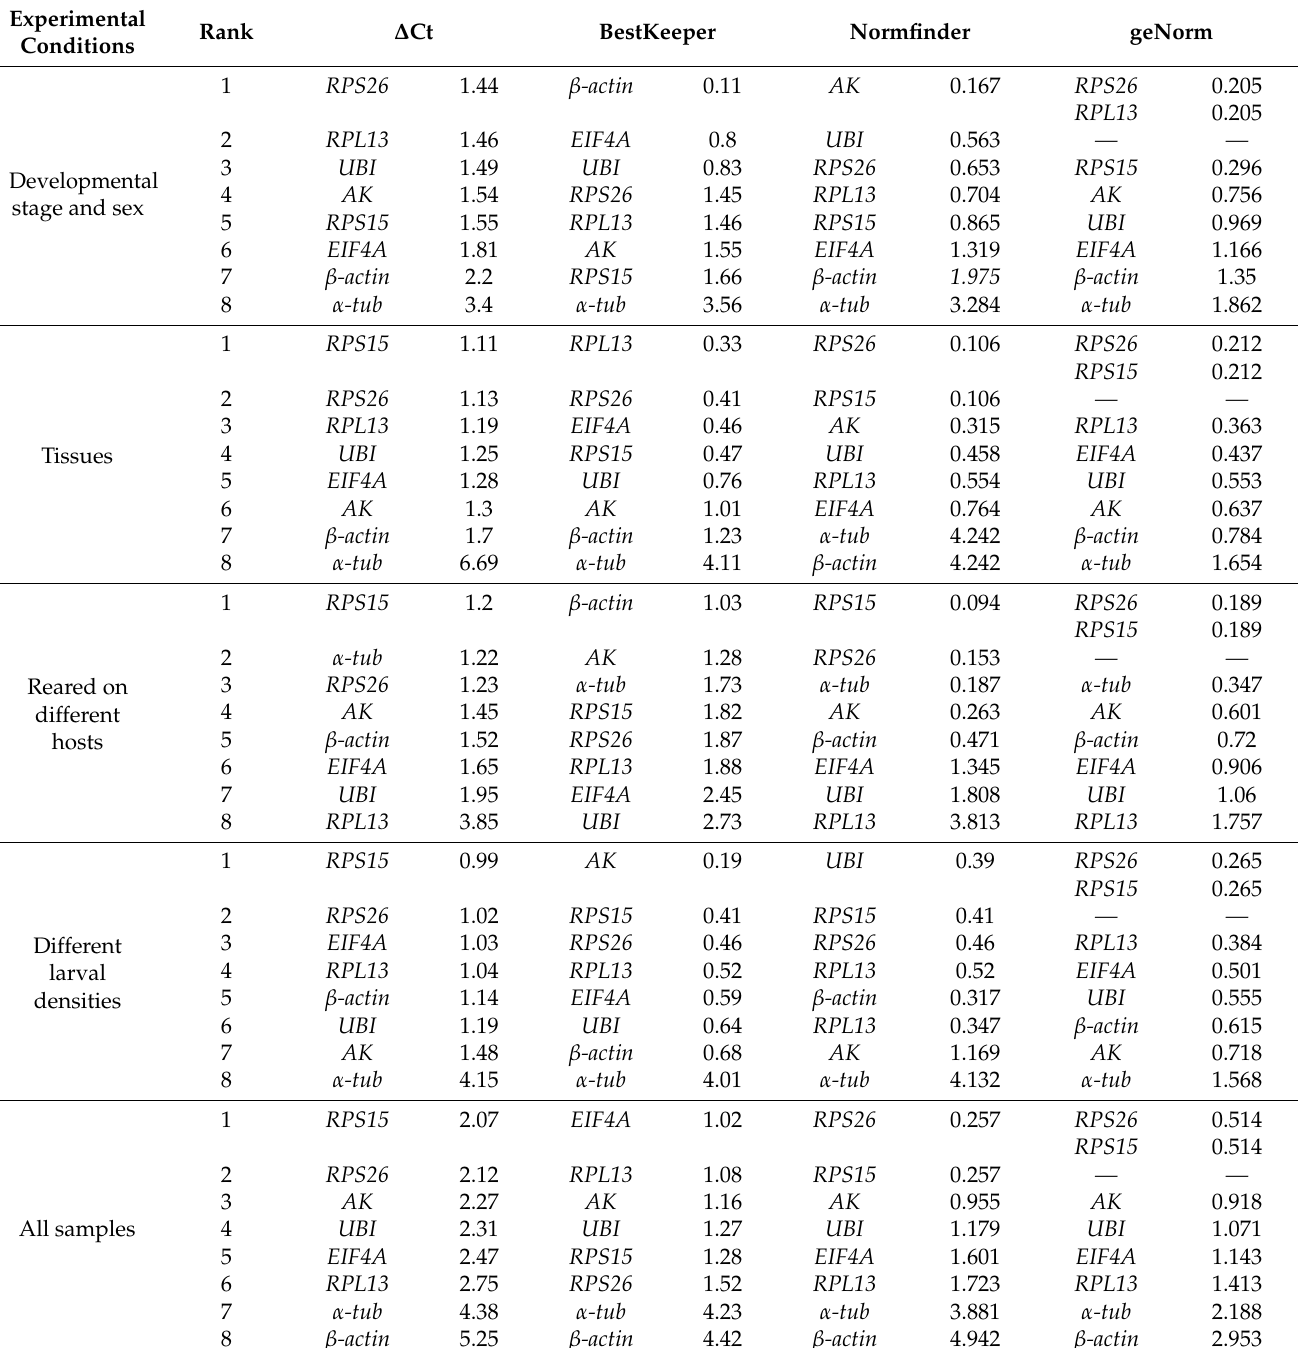
Table 1. Ranking of the candidate reference genes under different